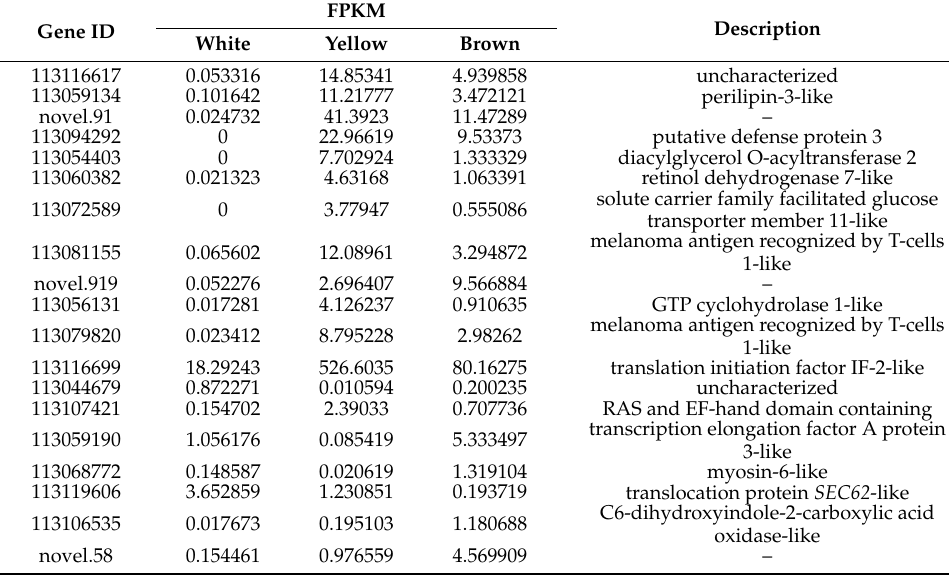
Table 1. A total of 19 common differentially expressed genes among three groups.